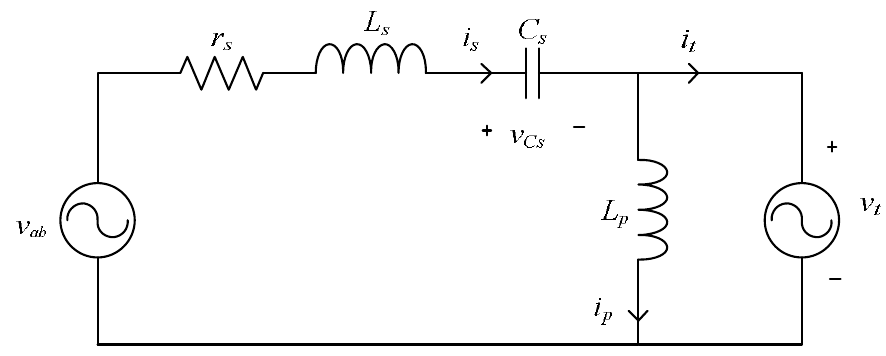
Figure 4. Equivalent circuit of the high-frequency (HF) ac